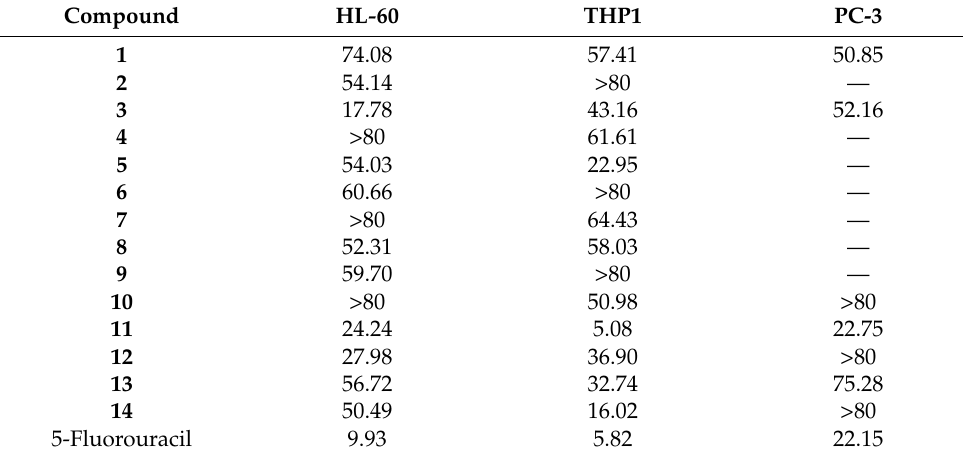
Table 3. Cytotoxicity data of compounds 1 – 14 a